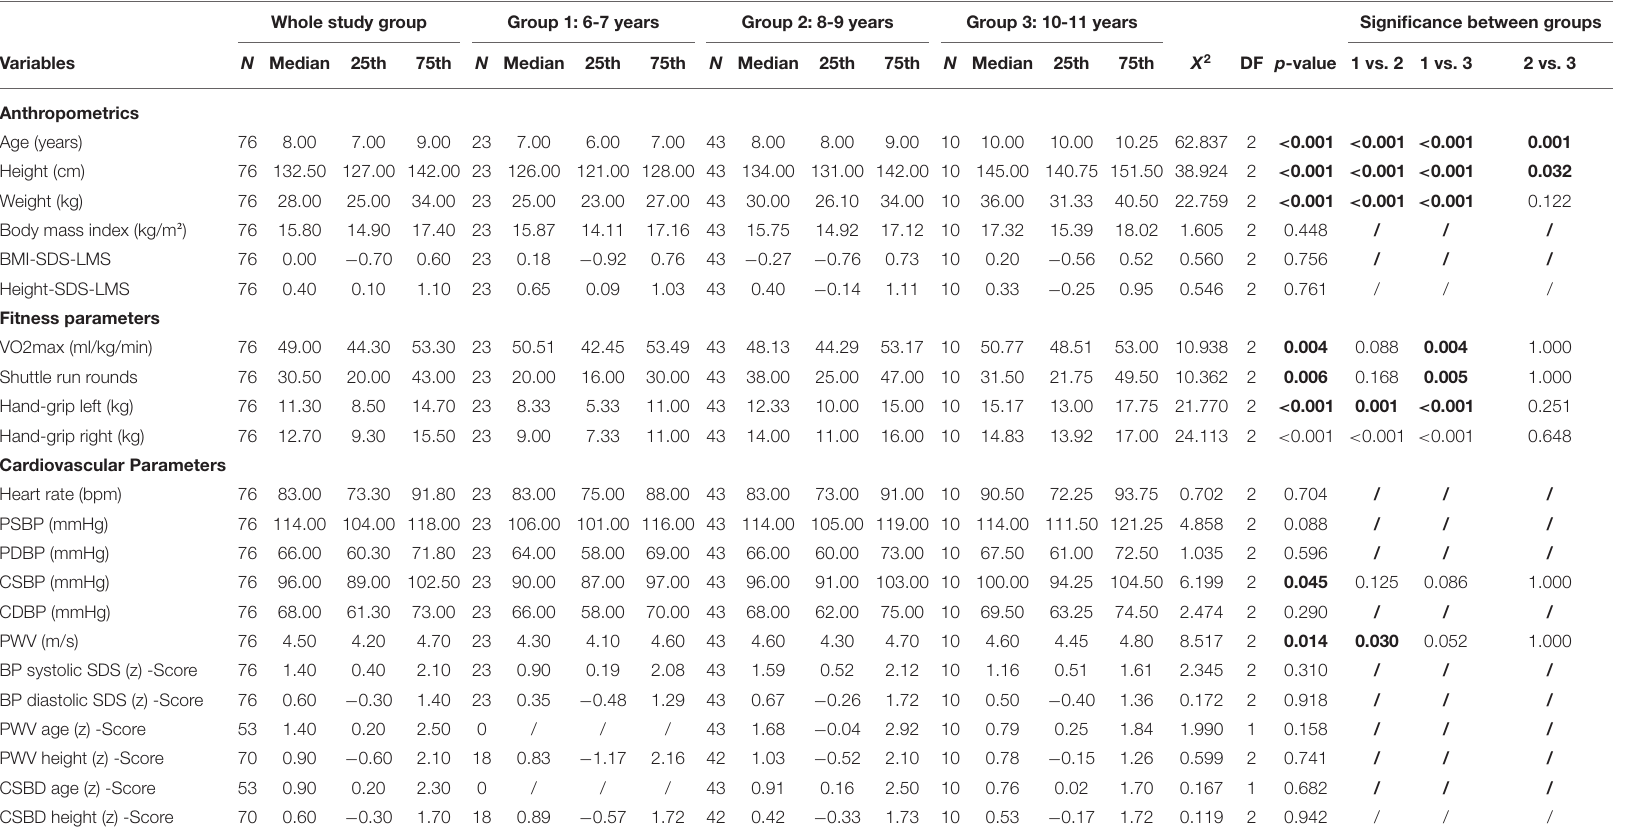
TABLE 2 | Subject characteristics according to age